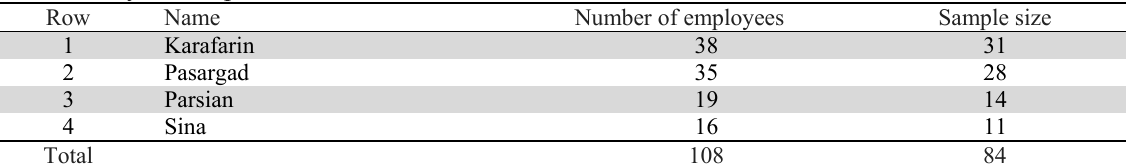
The summary of sample